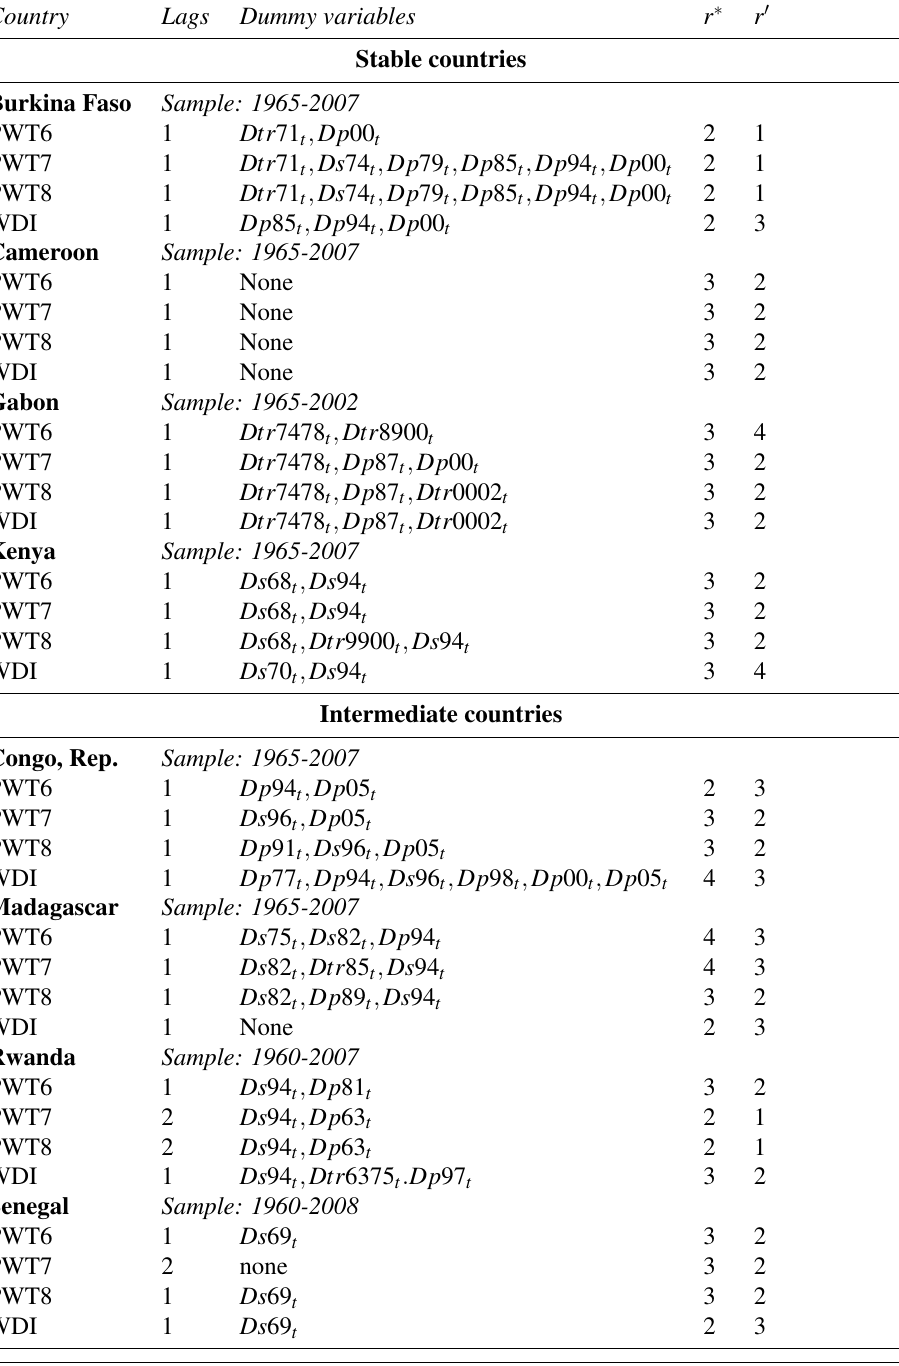
Table 9: Final model